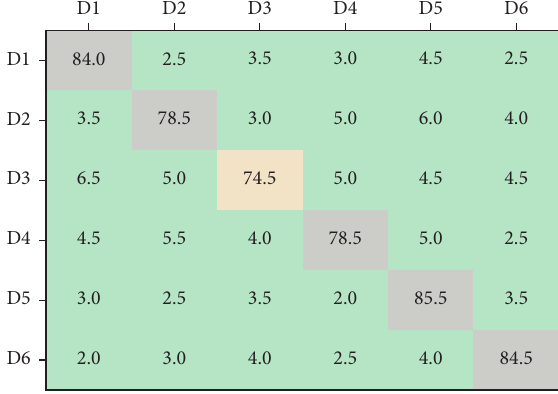
Figure 11: Confusion matrix of testing dialect identification system.